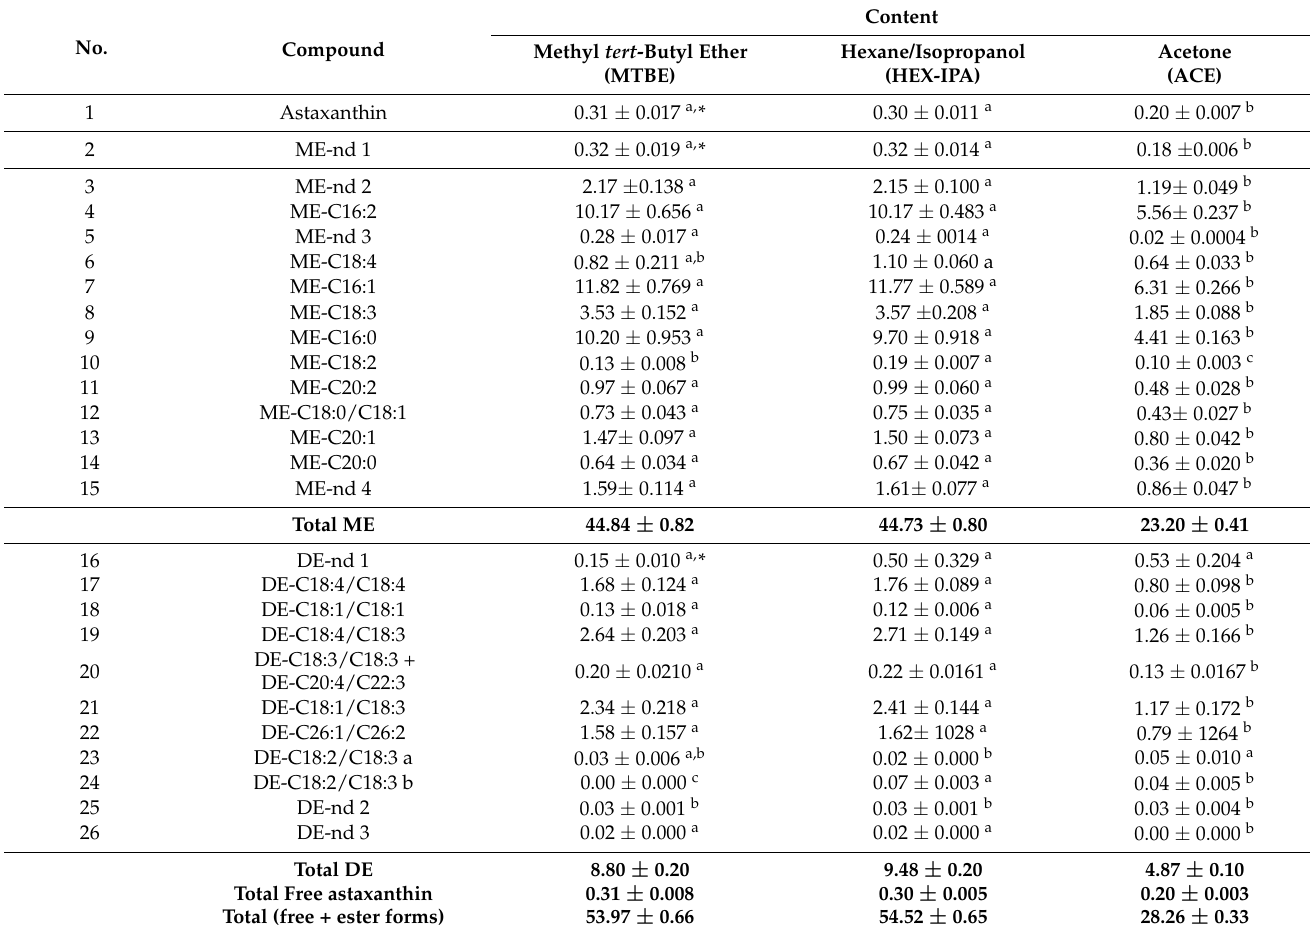
Table 2. Content of all detected astaxanthin, mono- and di- esters (mean ± SE, mg g − 1 DW) in H. pluvialis microalgae treated with different solvents.